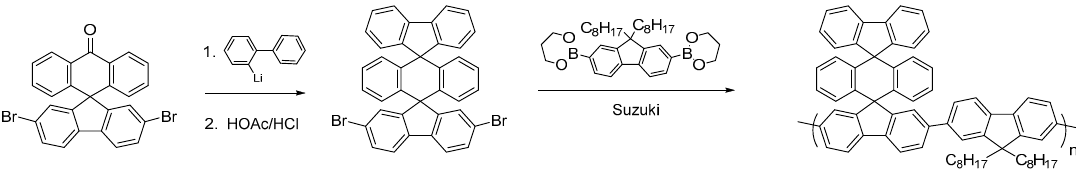
Figure 10. Synthesis of novel triple-decker spirocyclic conjugated polymer.